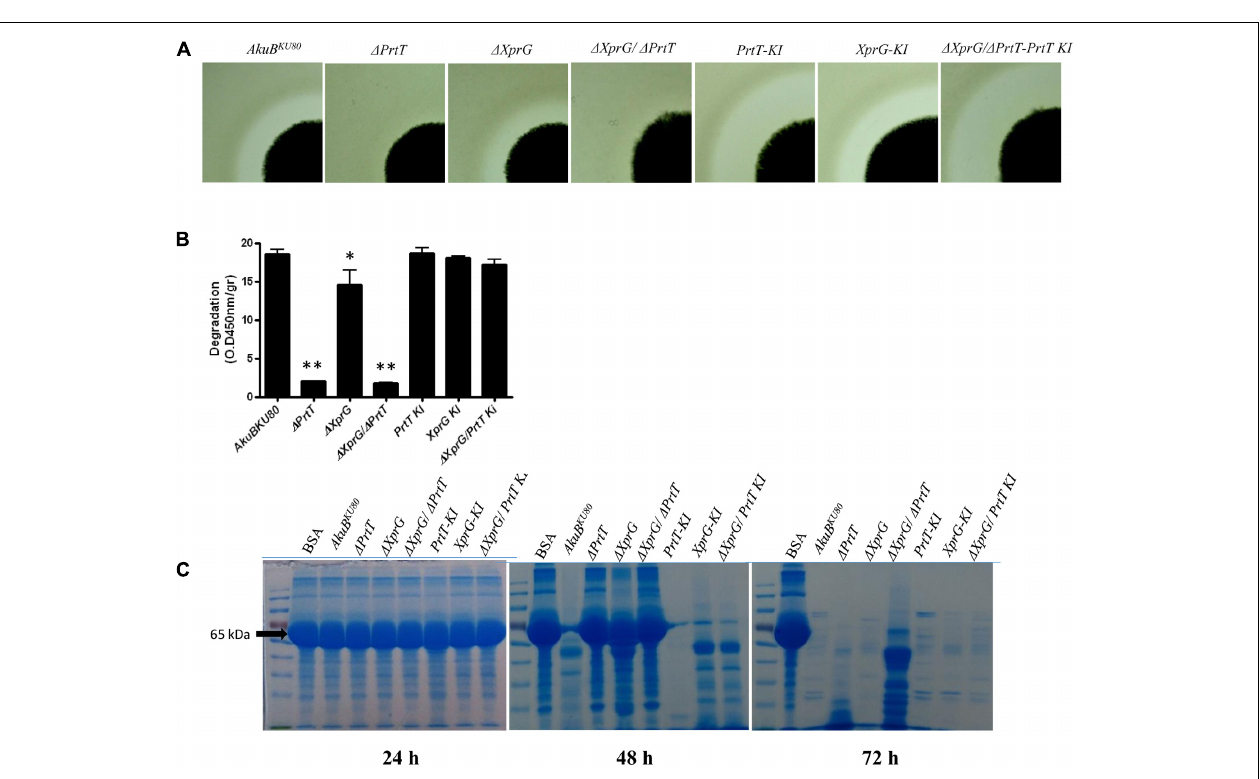
FIGURE 2 | The (cid:49) XprG and (cid:49) XprG/ (cid:49) PrtT mutants produce conidia that are more sensitive to chemical and mechanical stress. (A) 10 3 conidia/ml were suspended in 0.5% Tween 20 for the time indicated, plated and the number of colonies counted in comparison to controls suspended in DDW alone. ∗ P < 0.001 AkuB ku80 vs. (cid:49) XprG and (cid:49) XprG/ (cid:49) PrtT mutants. (B) 5 × 10 7 conidia/ml were agitated in the presence of acid-washed glass beads for the time indicated, plated and the number of colonies counted in comparison to untreated controls. ∗ P < 0.05 AkuB ku80 vs. (cid:49) XprG and (cid:49) XprG/ (cid:49) PrtT mutants.